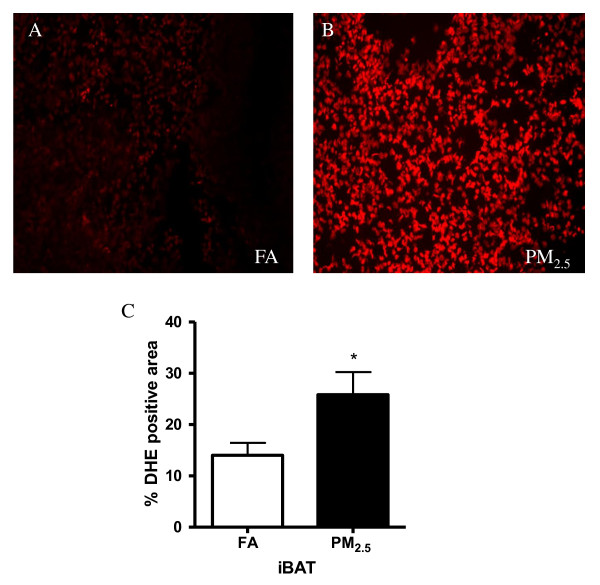
Exposure to PM2.5 resulted in increased superoxide production in iBAT. A. DHE staining of adipose tissue sections from the mice exposed to PM2.5 or FA for 2 months. Frozen iBAT sections were stained with DHE (10 μmol/L). The oxidative red fluorescence was analyzed by fluorescent microscope. B. DHE signals were quantified by the percentage of DHE-positive areas in 5 random fields. n = 8. *P < 0.05 vs. FA.